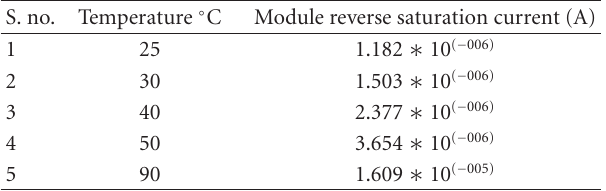
Table 3: I rs for various temperatures.